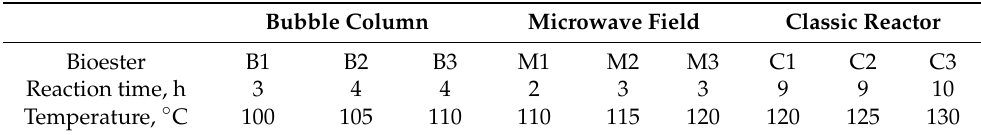
Table 1. The reaction conditions for soybean esters production in different technologies. Bubble Column Microwave Field Classic Reactor